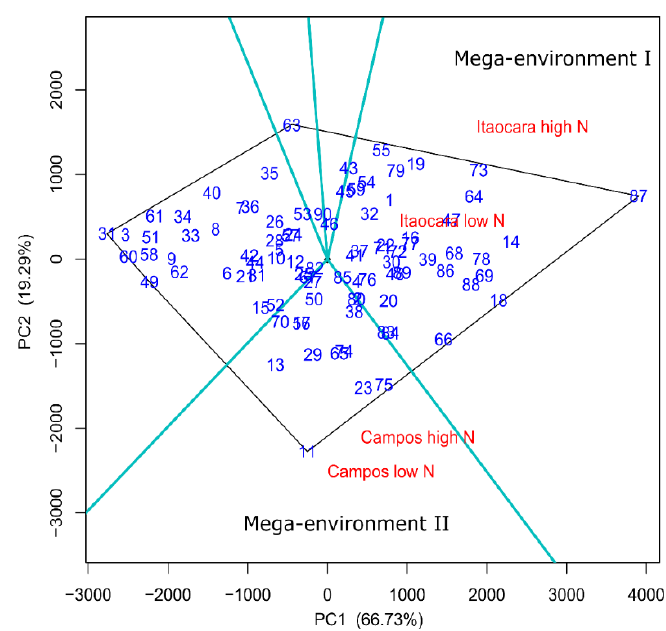
Figure 1. GGE biplot representing the “which-won-where” graph for maize grain yield, evaluated in environments under low and ideal N availability.